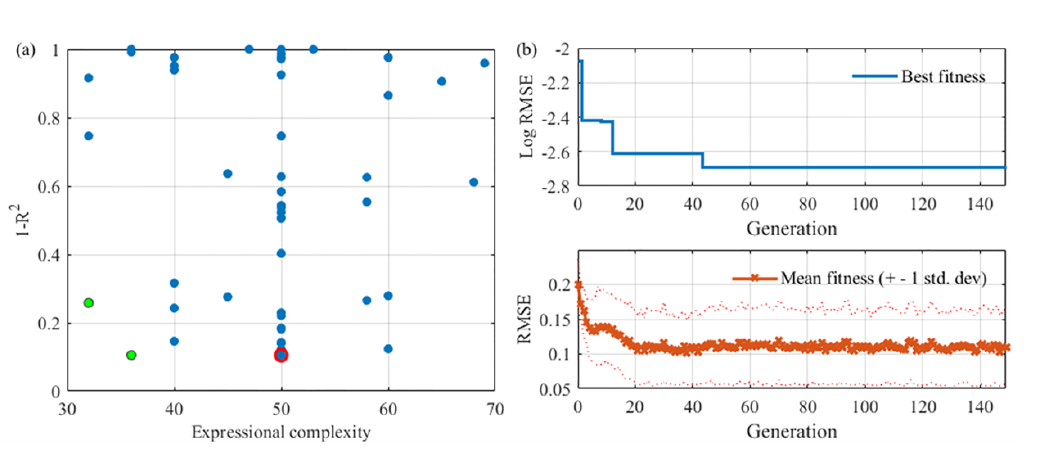
Figure 8. The actual and SGGP results: ( a ) results at all the data points; and ( b ) scatter plots of the actual and predicted results. The RMSE and R 2 values are also reported. For the training data sets, the predictions of the best SGGP model (RMSE = 0.068, R 2 = 0.895) were obviously less accurate than the MGGP Models A and B but more accurate than the MGGP Model C. In terms of the testing data sets, the RMSE and R 2 values in the SGGP predictions were 0.063 and 0.888, respectively, which also demonstrated that the performance of the SGGP model was better than the MGGP Model C but worse than the MGGP Models A and B. In summary, the above findings revealed the superior performance of MGGP in evolving an accurate model over the SGGP algorithm. However, the lower RMSE and higher R 2 values compared with the MGGP Model C indicate that an SGGP-based model could have higher prediction capability than an MGGP model that is over simplified. 3.5. Comparison with the Existing Empirical Equation